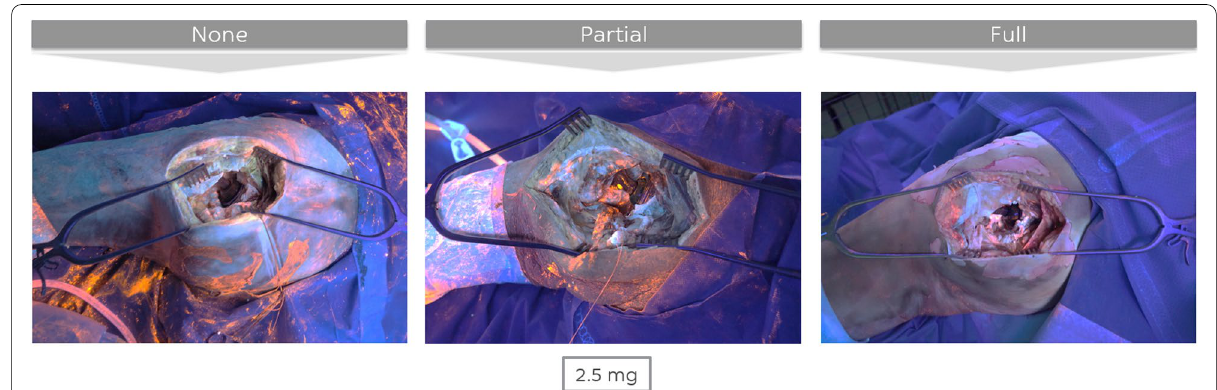
Fig. 7 Surgical wound at the end of the one-step exchange for three different clean phase protocols (bacterial load 3